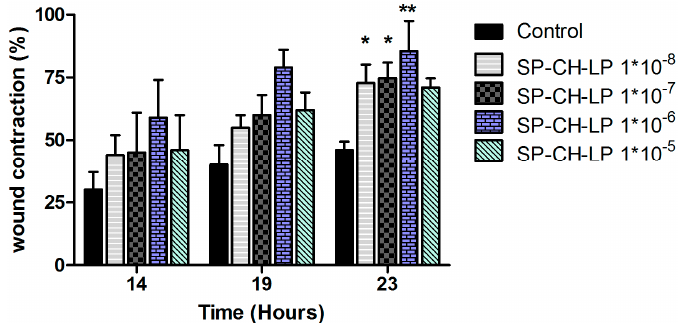
Figure 6. Effect of treatment with varying concentrations of liposome-encapsulated substance P on relative wound healing in HaCaT cells registered at varying times, as measured by Ibidi ® in vitro wound healing assay over 23 h. (Data represent the mean average ± standard deviation, n = 3 to 6; cell culture media (DMEM) with supplements were used as control; stars on bars represent significant differences respect to control by ANOVA with the Tukey multiple comparison test * p < 0.05, ** p < 0.001).